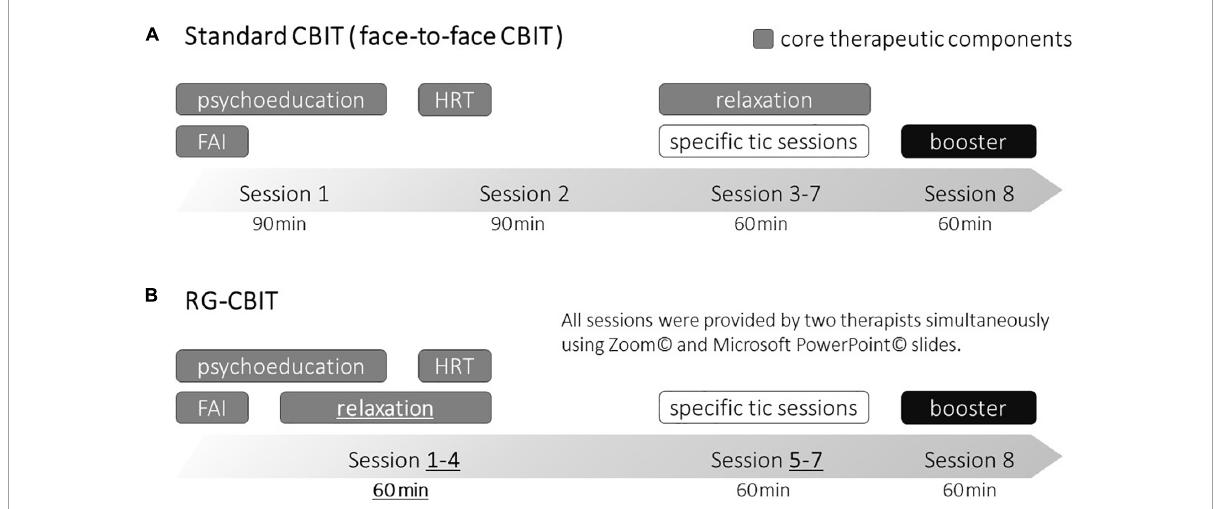
FIGURE1 Difference between RG-CBIT and standard CBIT. FAI , functional assessments and interventions; HRT , habit reversal training; RG-CBIT , remotely administered group comprehensive behavioral intervention for tics; CBIT , comprehensive behavioral intervention for tics. The upper part (A) is a schematic diagram of the standard CBIT, and the lower part (B) is a schematic diagram of RG-CBIT. The dark gray cells indicate core therapeutic components. There were three primary differences between RG-CBIT and the standard CBIT (underline and bold text). First, the duration of all sessions were changed to 60 min. Second, the learning relaxation components were moved to the first session. Third, the core therapeutic components were trained in the first four sessions (combined 240 min) rather than the first two sessions (combined 180